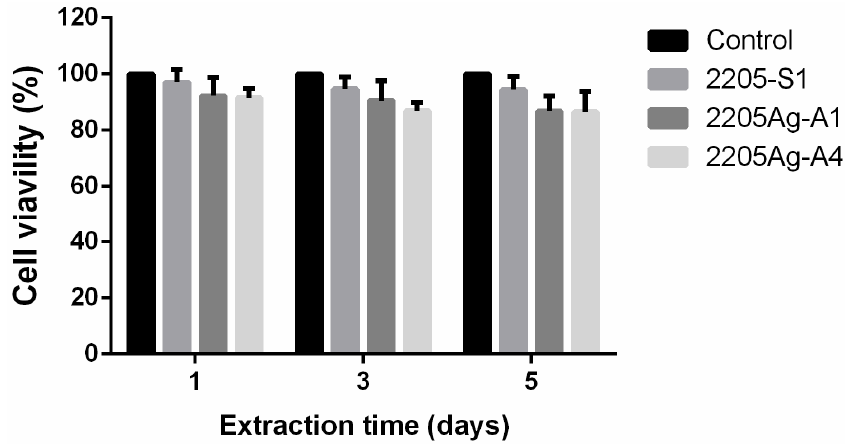
Figure 7. Cytotoxicity test after culturing with different extraction times from different specimens for 24 h.